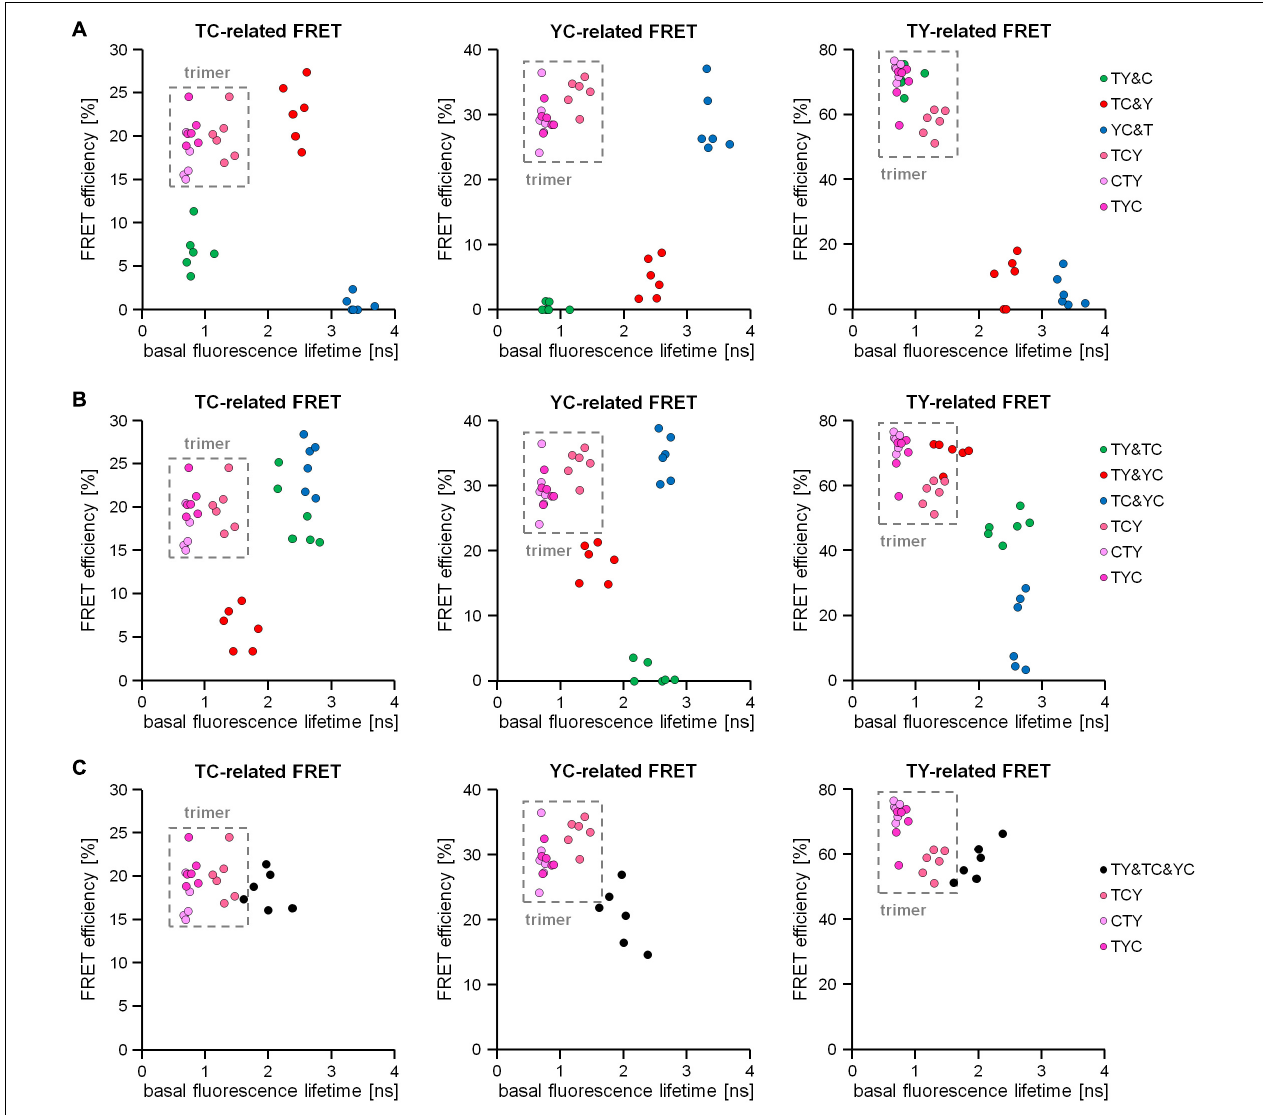
FIGURE 6 | Discrimination of trimeric from dimeric interactions by using a combination of acceptor photobleaching and the basal donor fluorescence lifetime assessment. Correlation of the basal fluorescence lifetime of mTurquoise2 with the intensity-based TC-FRET, YC-FRET and TY-FRET-related FRET efficiencies obtained from the acceptor photobleaching of the same cell ( n = 6 each). (A) Discrimination of trimeric interactions (FRET triplets TCY, CTY, TYC) from dimeric interactions (FRET doublets TY&C, TC&Y, YC&T) in this correlation. In all three FRET types (T > Y; T > C; Y > C) investigated, the trimeric interaction-related data points occupy the upper left quadrant of the correlation plots (marked as a gray rectangles), while the data points of the dimeric interactions are predominantly located in other quadrants. (B) Discrimination of the trimeric interactions (FRET triplets TCY, CTY, TYC) from double-dimeric interactions (double FRET doublets TY&TC, TY&YC, TC&YC) using the same correlation plot system. Again, data points derived from double-dimeric interactions are mostly located outside the upper left quadrant. (C) Correlation plots deduced from trimeric interactions (FRET triplets TCY, CTY, TYC) and triple-dimeric interactions (TY&TC&YC). Note that due to dilution effects on mTurquoise2 lifetime in the basal unbleached state as well as distinguishable responses after acceptor photobleaching, data distribution in TY&TC&YC samples clearly differs from data distribution in TCY, CTY or TYC samples,